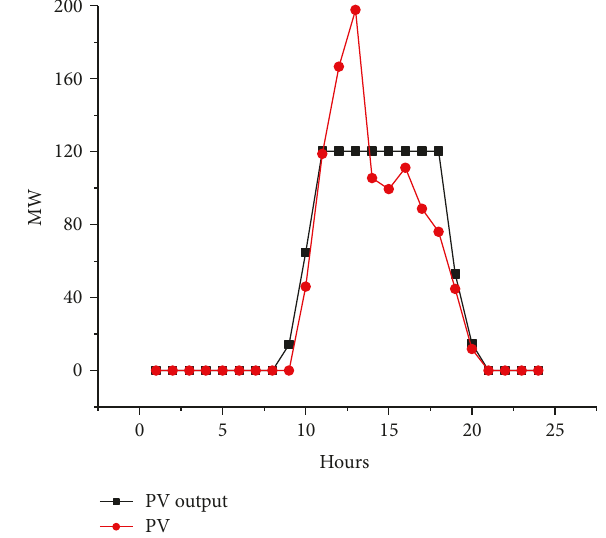
Figure 8: Comparison between the power generation capacity of PV system and the actual power generation on Equinox